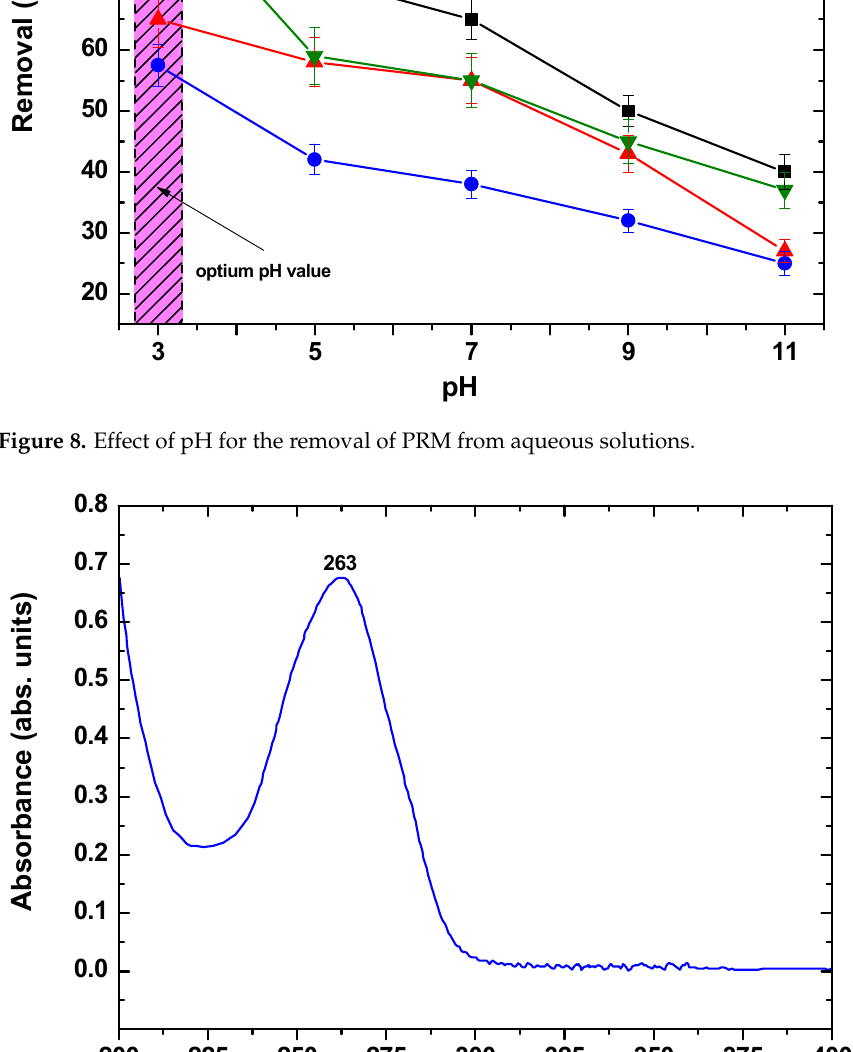
Figure 9. UV-Vis spectrum of PRM after 24 h (hydrolysis experiment). Another reason for the observed effect of pH on the adsorption may be the suppression of the complexation. In solutions with a low pH value, some functional groups are protonated (or difficult to dissociate) and the complexation between PRM and the functional groups on the surfaces of the activated carbons increases. Additionally, based on the above FTIR results, it can be concluded that strong pi-pi electron coupling and/or stacking (mainly dispersion forces) between PRM molecules and aromatic rings of the carbon may be the adsorption mechanism. The benzene rings of the drugs as well as their aromatic heterocyclic rings are expected to interact with the polarized aromatic rings on carbons via the mechanism of pi-pi electron coupling [28,55]. Additionally, the Lewis acid–base interaction, where the amino groups of PRM molecules are the Lewis bases and the O-containing groups of carbons serve as Lewis acids, may be another important mechanism of adsorption of PRM. The presence of lone pairs of electrons on nitrogen atoms produces dipolar moments for PRM. Negative charges are close to these nitrogen atoms and the presence of the polar oxygen groups on the carbon surface with a lone pair of electrons on their oxygen atoms may be the reason for surface specific interactions between the oxygen surface groups of carbon samples and PRM molecules [28]. The lat- ter was in accordance with another study [28], in which the adsorbent material was ac- tivated carbon produced from potato peels and the pollutants adsorbed were pharma- ceutical compounds (pramipexole and dorzolamide). 3.2.2. Equilibrium/Isotherms Figure 10 depicts the curves of the isotherms for the pramipexole adsorption from aqueous solutions. Additionally, the isothermal parameters that resulted from the ex- perimental data fitting of Langmuir and Freundlich models are reported in Table 3.